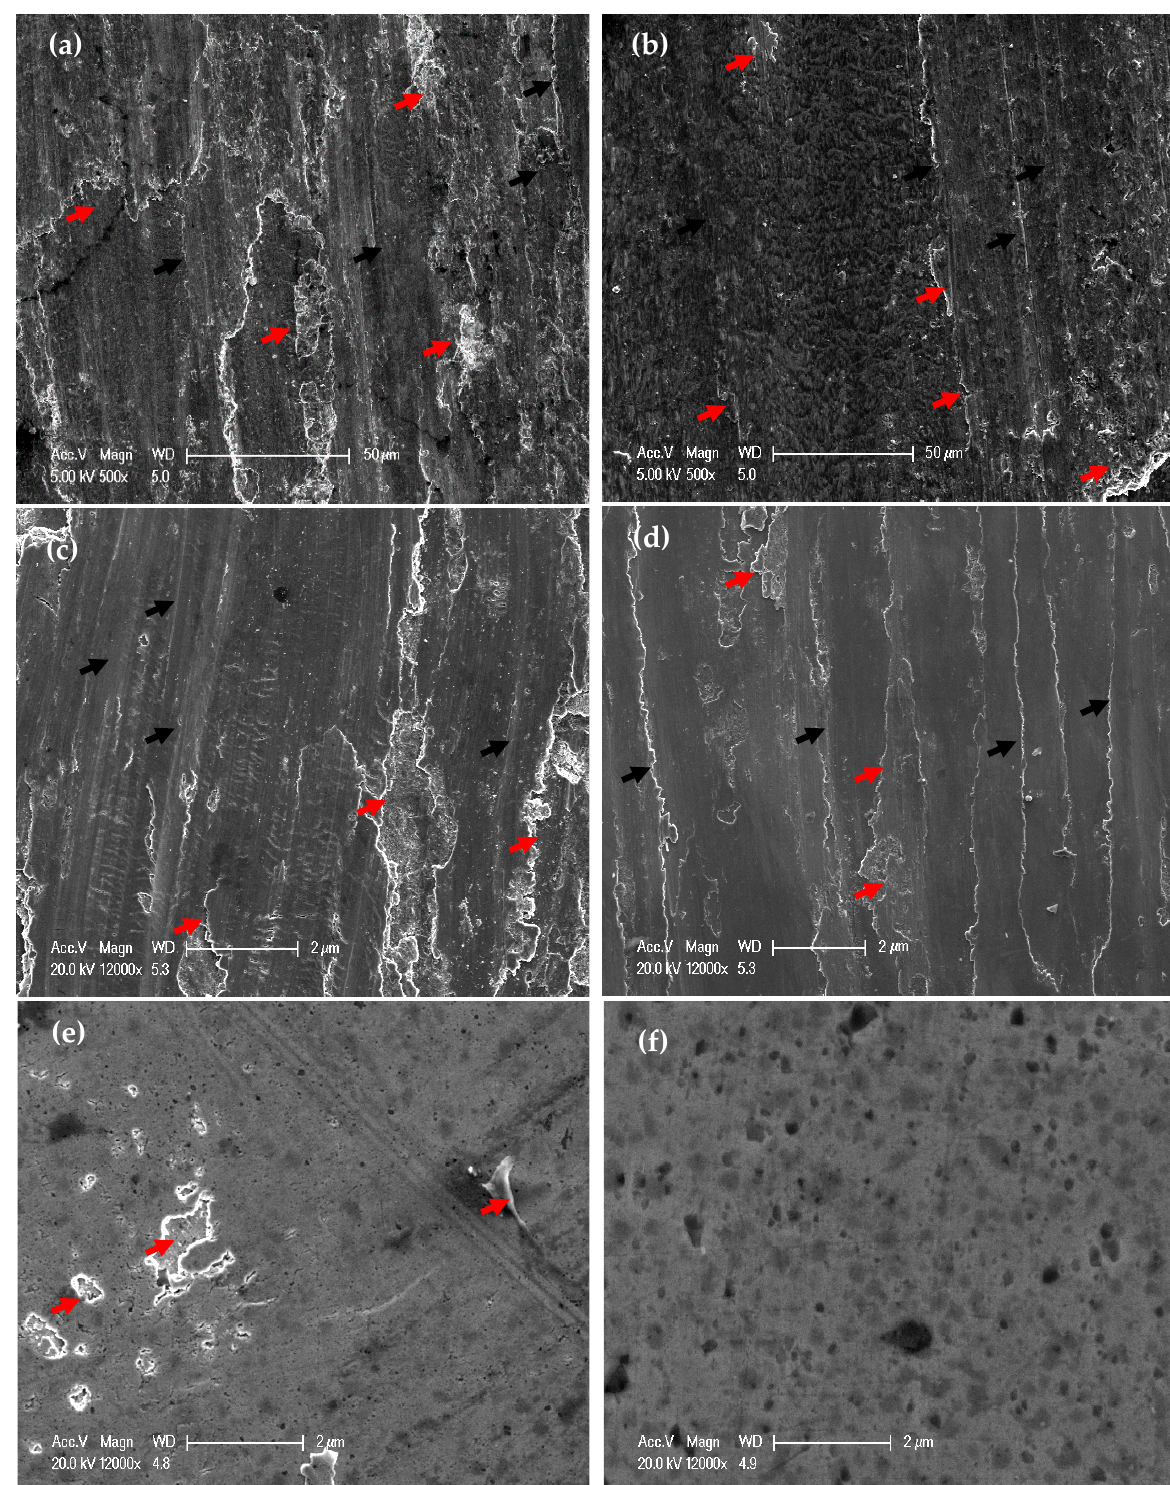
Figure 9. Worn surface morphology of ( a ) PM Al-20% Al 2 O 3 , ( b ) PM Al- 20% SiC, ( c ) HPT-processed Al-10% Al 2 O 3 , ( d ) HPT-processed Al-10% SiC, ( e ) HPT-processed Al-20% Al 2 O 3 , and ( f ) HPT- processed Al-20% SiC samples obtained under an applied load of 2.5 N and a sliding distance of 315